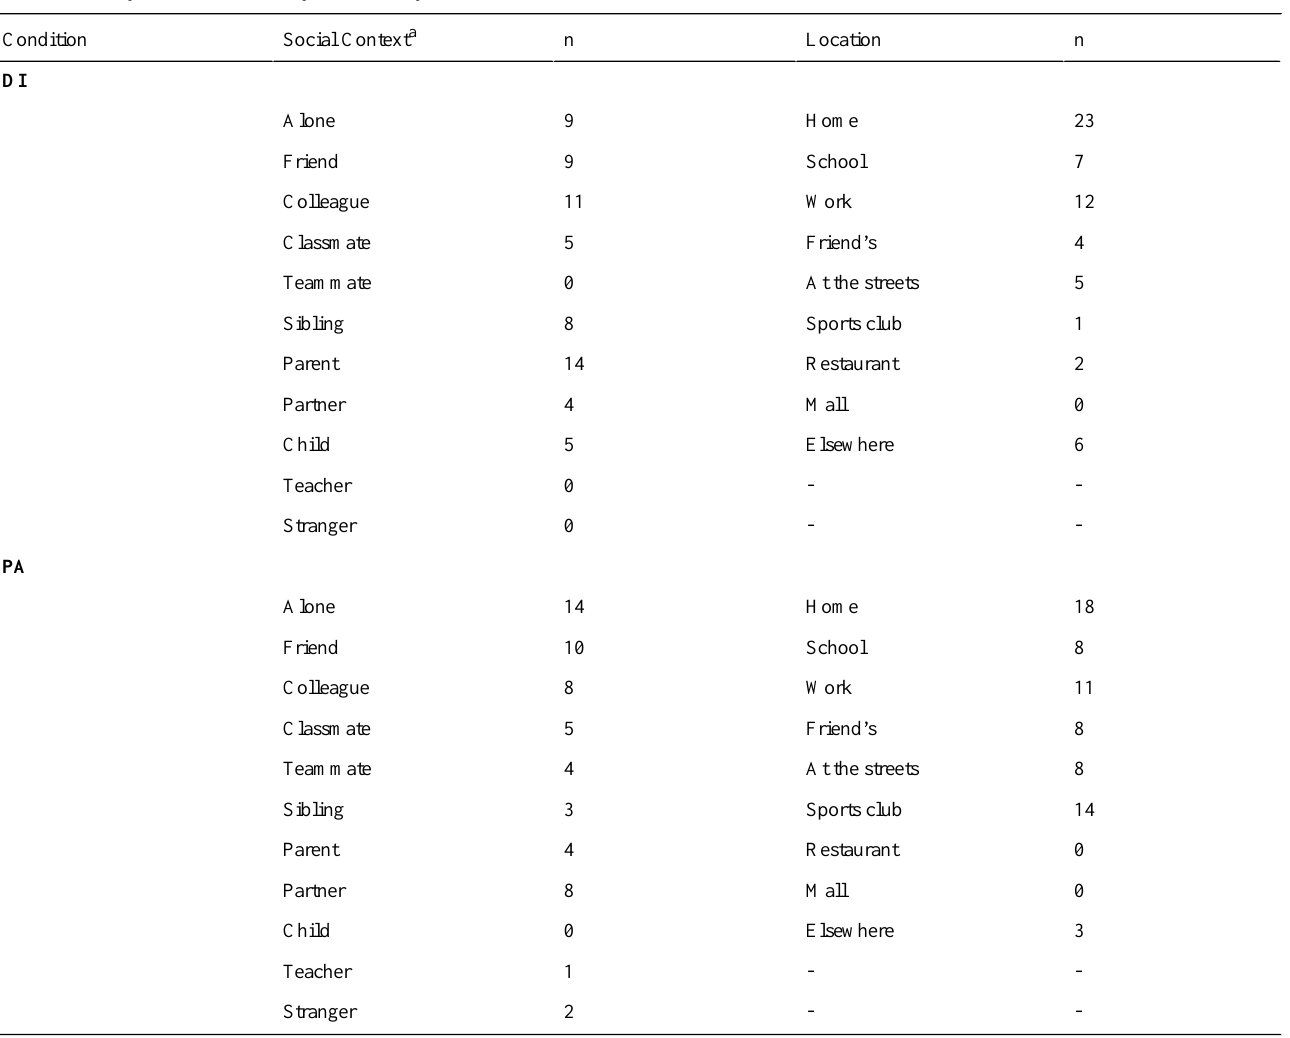
Table 3. Dietary Intake (DI) and Physical Activity (PA) related to social context and